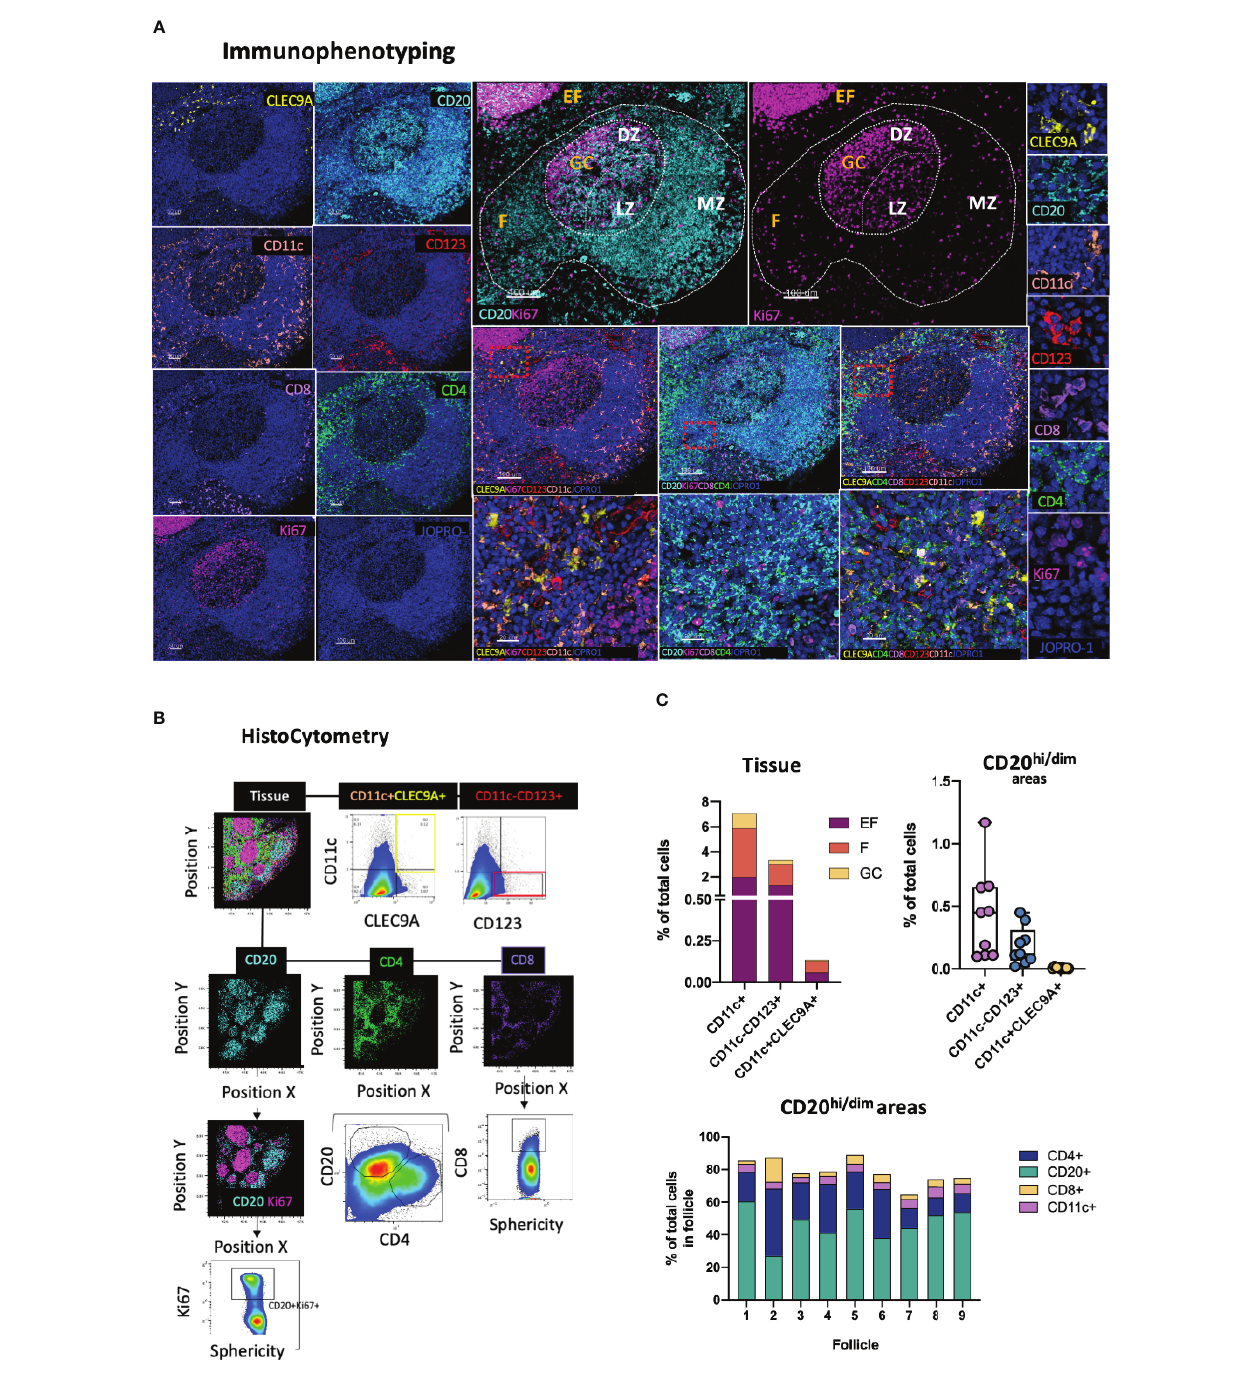
FIGURE 7 | Development of a multispectral panel for the topological examination of DCs. (A) Representative images showing staining for CLEC9A (yellow), CD20 (cyan), CD11c (orange), CD123 (red), CD8 (pink), CD4 (green), Ki67 (magenta) and JOPRO-1 (blue) in a tonsillar tissue section and the distribution of each protein marker with respect to the MZ, LZ and DZ (middle panels). Red dotted square enclosures in lower middle panels denote the areas that are presented magni fi ed in the lower middle panels. (B) Gating strategy used for the sequential positional immunophenotyping of CD4, CD8, CD20, CD11c+, CD11c+CLEC9A+CD123- and CD11c-CD123+CLEC9A- in GC (CD20 dim Ki67 hi ), F (CD20 hi/dim ) and EF (CD20 lo ) areas using histocytometry. (C) Box graphs and box plots showing the relative frequencies of CD11c+, CD11c+CLEC9A+CD123- and CD11c-CD123+CLEC9A- immune cells in tonsillar tissue as well as in CD20 hi/dim areas (upper panels) and relative frequencies of CD20, CD4, CD8 and CD11c+ immune cells in nine individual follicles. Images were acquired at 40x (NA 1.3) with 1% magni fi cation. Scale bars are 100um for all panels displaying an entire follicle), 20um in the middle panel close ups and 5um in the right panel single staining close